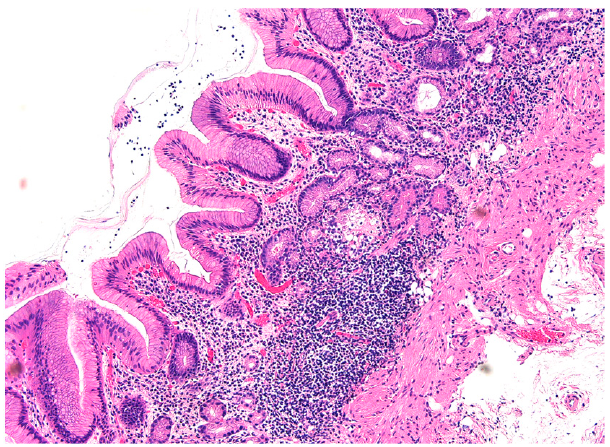
Figure 1. Histopathological image of AIG. Lymphocytic infiltration is observed in the deep layer of the lamina propria. The parietal cells in the lamina propria almost disappear. On the other hand, the density of the glandular epithelium is relatively maintained.